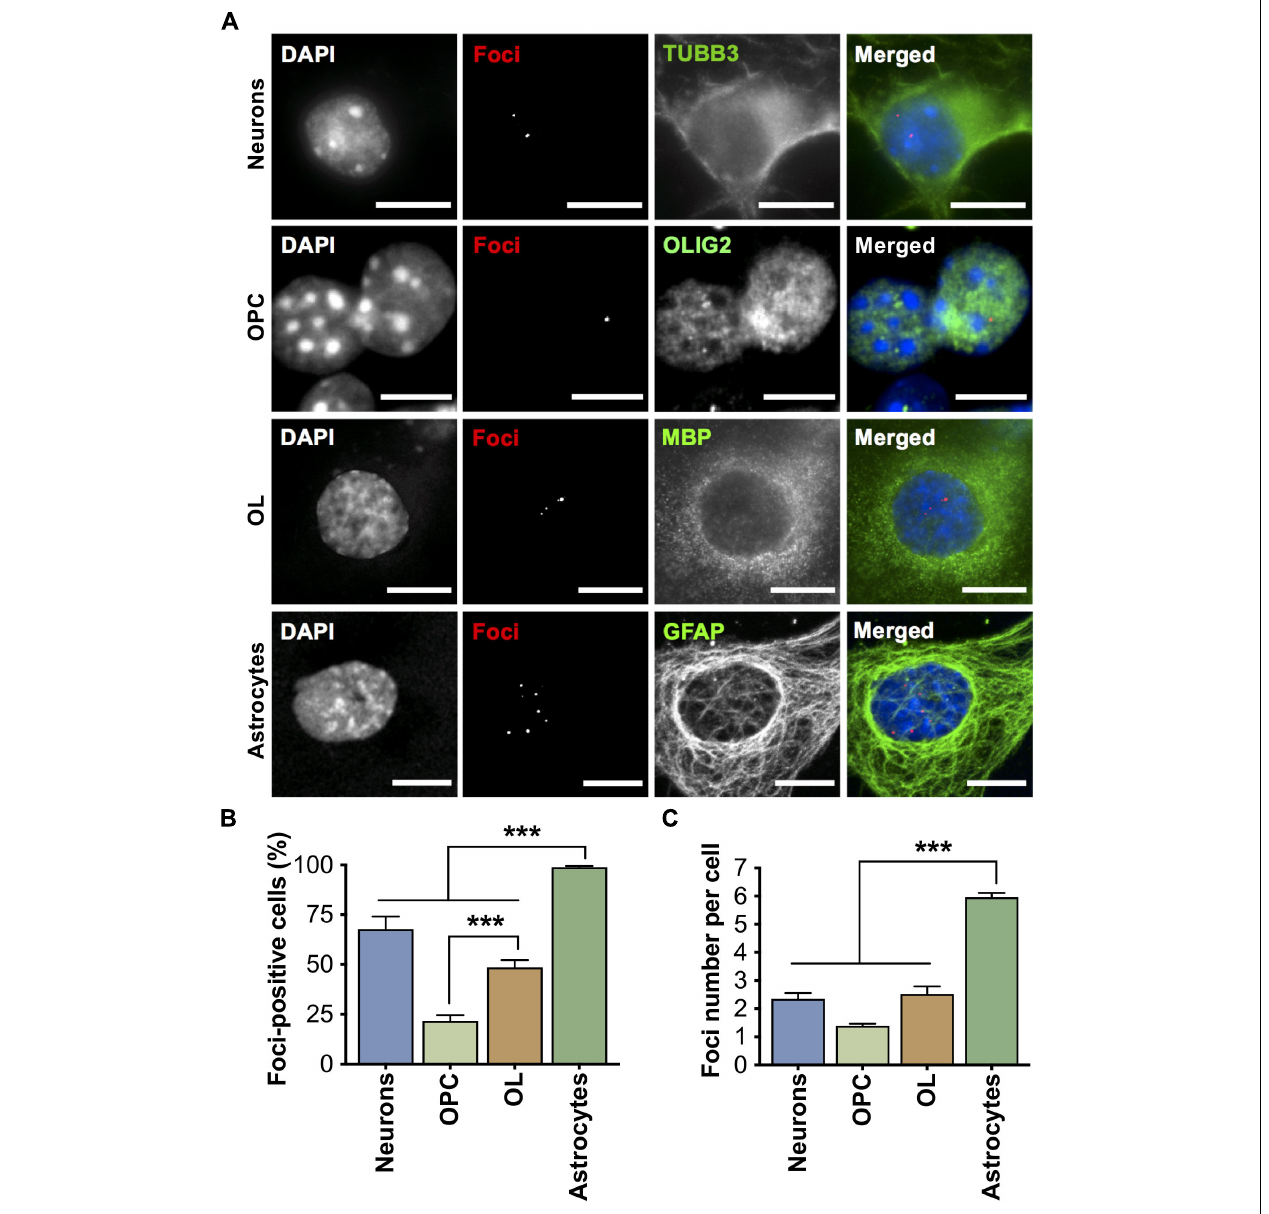
FIGURE 2 | Accumulation of expanded CUG ribonuclear foci in primary DMSXL brain cells. (A) Foci accumulation in DMSXL neurons, OPC, OL, and astrocytes was detected by FISH, in combination with immunofluorescence of cell type-specific markers (Neurons, TUBB3; OPC, OLIG2; OL, MBP; Astrocytes, GFAP). Scale bars represent 10 µ m. (B) Percentage of cells containing at least one focus. Data are average ( ± SEM). (C) Quantification of the number of foci per nucleus. Data are average ( ± SEM), n ≥ 7 cultures per cell type, n ≥ 125 cells per cell type (*** p < 0.001; one-way